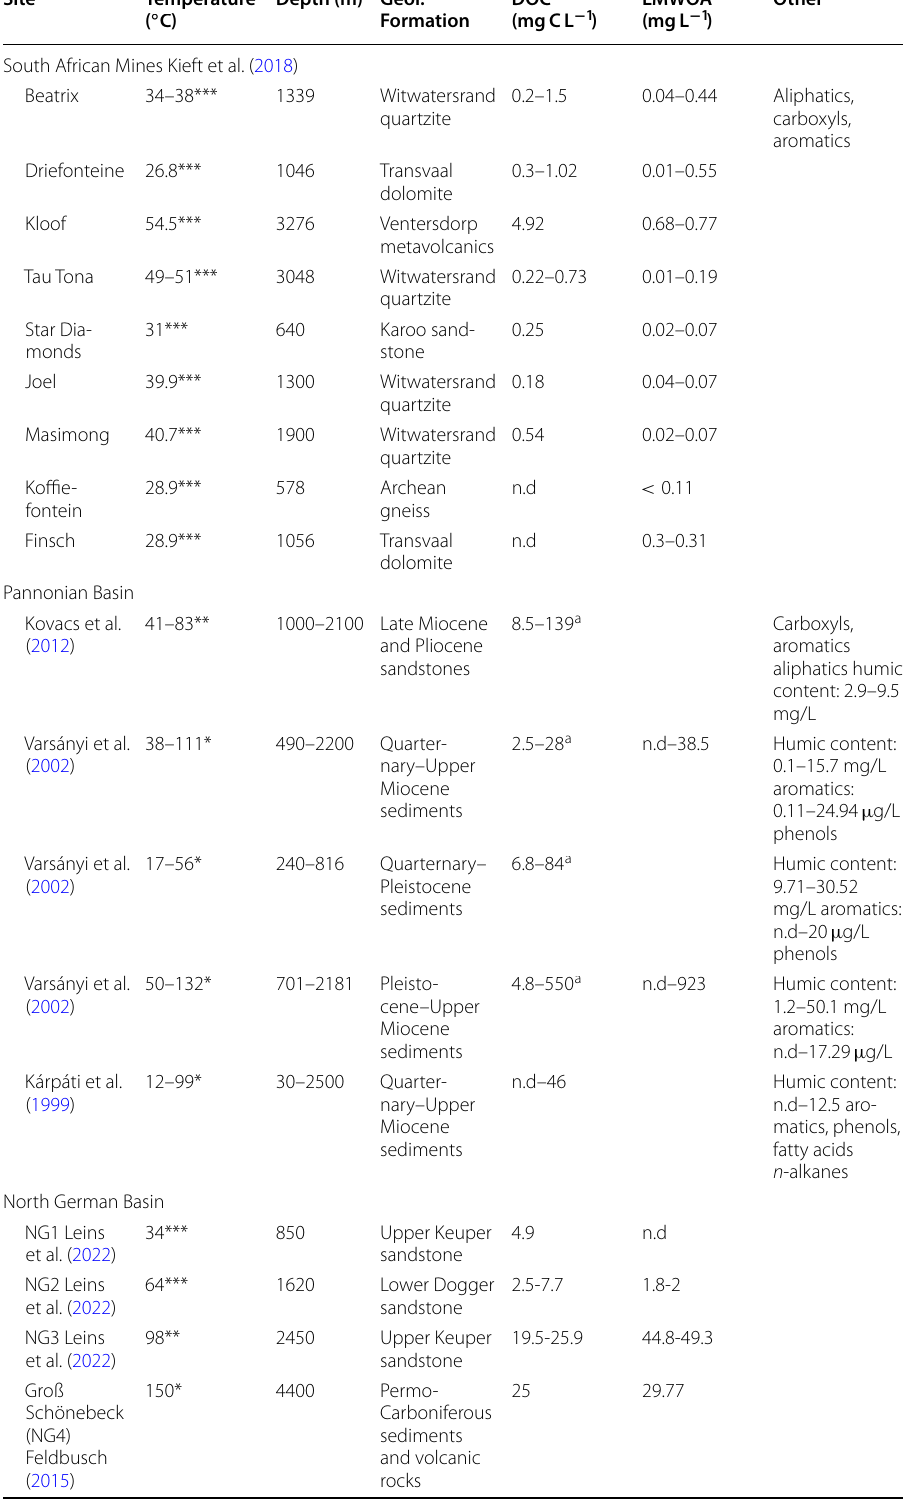
Table 1 Overview on DOC and LMWOA concentrations, and DOC composition in water samples from different geothermal regions of the world Site South African Mines Kieft et al.